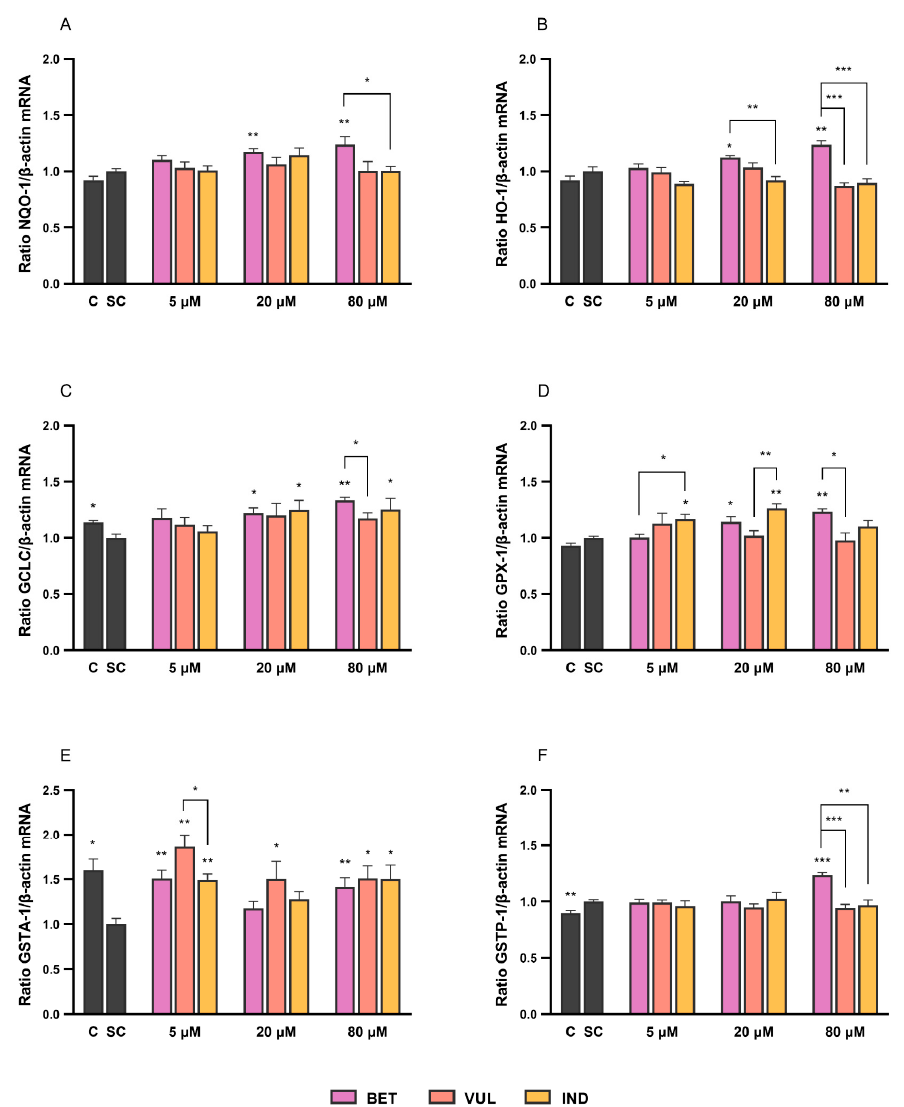
Figure 3. Effects of BET, VUL and IND (5, 20 and 80 μ M) on mRNA levels of ( A ) NQO-1, ( B ) HO-1, C and SC refer to negative medium control and cytokine-stimulated control, respectively. Data